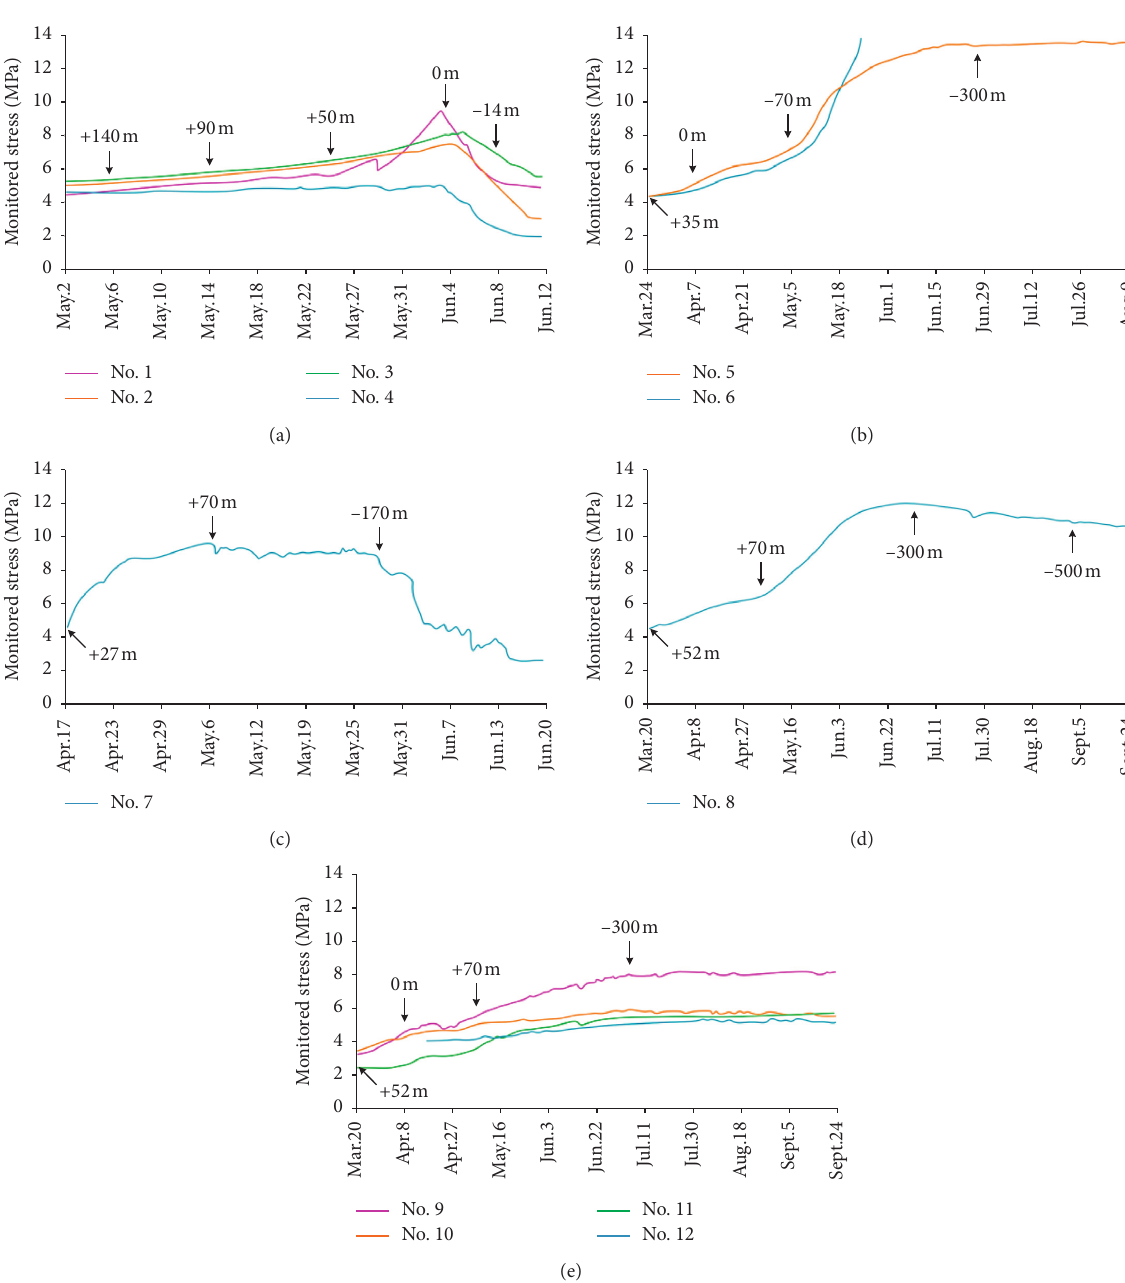
Figure 8: Stress monitoring curve of measuring points in A ∼ E interval. Note. +140 m means that the measuring point is located 140m ahead of the working face; − 14m means that the measuring point is located 14m behind the working